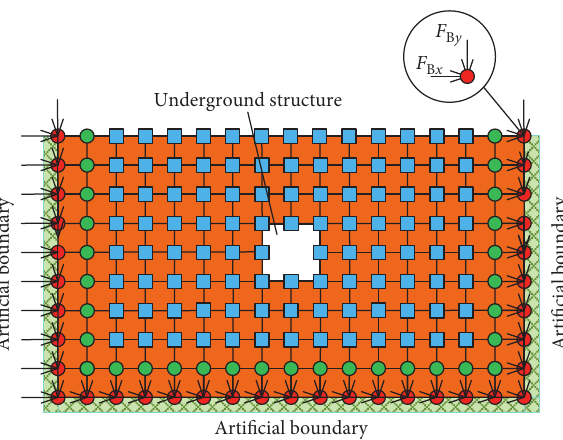
Figure 2: Seismic response analysis model of the SSI